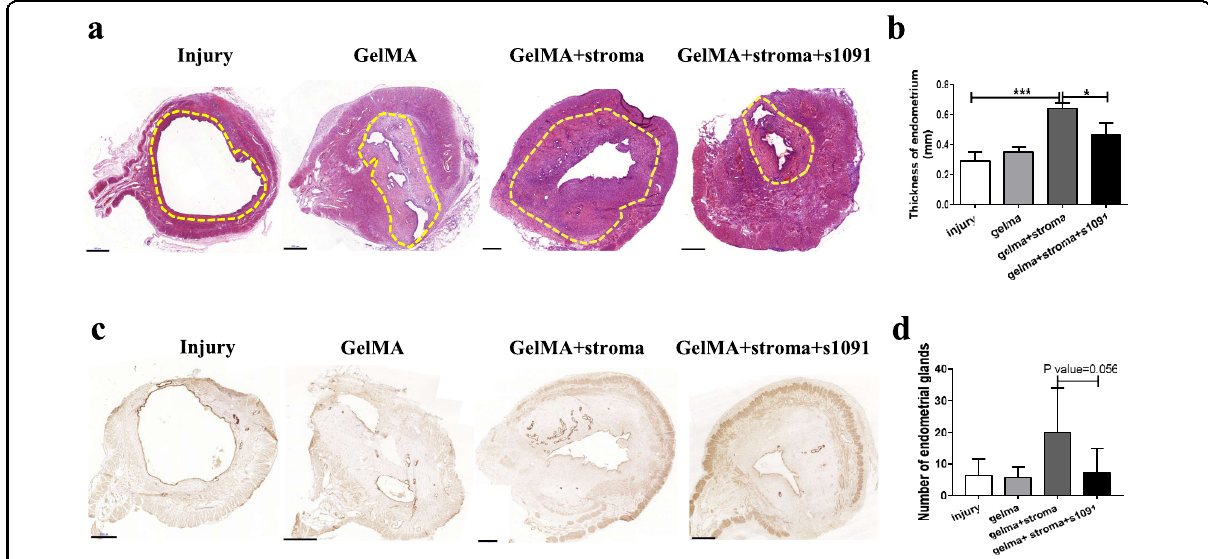
Fig. 5 SFRP4 + stromal cells promote the regeneration of endometrial epithelial glands and full thickness endometrial injury through IGF1 signaling pathway in vivo. a H&E staining of rat uterus 1 week after operation in endometrial injury group (injury), material only group (Gelma), SFRP4 + stromal cell therapy group (Gelma + stroma) and cell compound IGF1 inhibitor group (Gelma + stroma + s1091). b comparison of endometrial thickness in different operation groups, n = 5, * p < 0.05; *** p < 0.001. c Immunohistochemical staining of FOXA2 showed endometrial glands 1 weeks after after operation in injury group, Gelma group, Gelma + stroma group and Gelma + stroma + s1091 group. d quanti fi cation of endometrial glands in in different operation groups, n = 5. scale bar, 500 μ